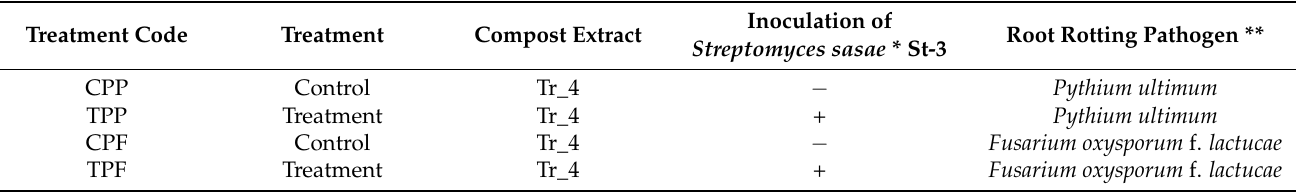
Table 3. Experimental conditions for determining the inhibition effect of Streptomyces sasae St-3 on plant pathogens against radish germination in the presence of the functional compost extract using petri dishes. Treatment Code